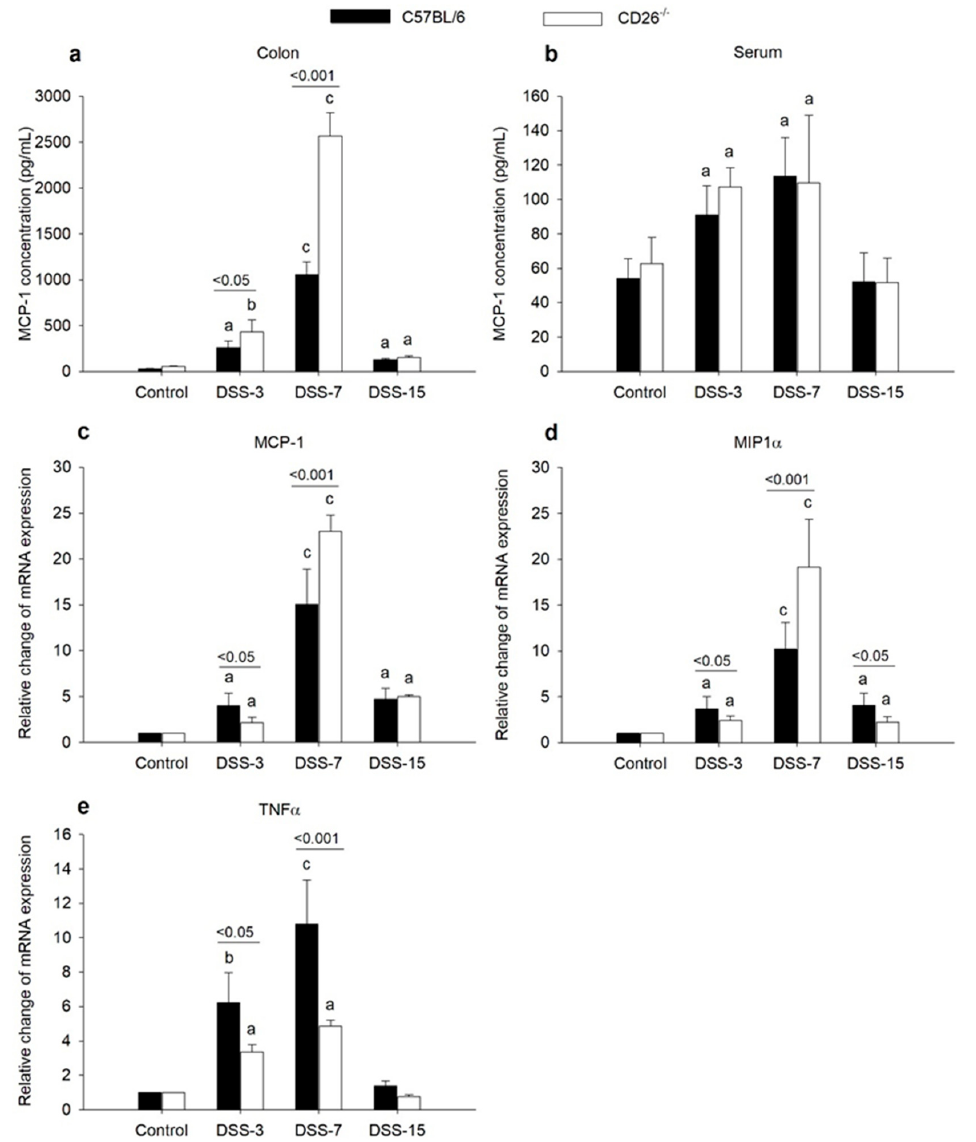
Figure 3. The influence of CD26 deficiency on concentration and mRNA expression of proinflamma- tory mediators MCP-1 concentration in colonic tissue ( a ) and serum ( b ) of C57BL/6 and CD26 − / − mice with DSS-induced colitis was determined using enzyme-linked immunosorbent assay (ELISA). The analysis was performed on days 3, 7, and 15 after colitis induction with DSS in both mouse strains. Relative quantification of MCP-1 ( c ), MIP1 α ( d ), and TNF α ( e ) gene expression in colonic tissue was determined by quantitative real-time (RT)-PCR on days 3, 7, and 15 after colitis induction. Data are expressed as mean ± SD. n = 6 mice/each group. a, b, and c denote p < 0.05, p < 0.01 and p < 0.001 compared with the control group, respectively. Comparisons between related DSS-treated C57BL/6 and CD26 − / − groups are highlighted by horizontal lines above the bars.